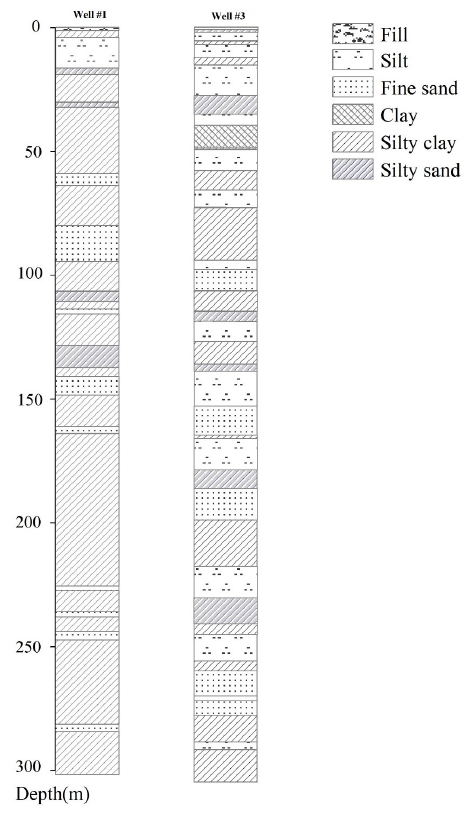
Figure 13. Schematic description of Well #1 and Well #3